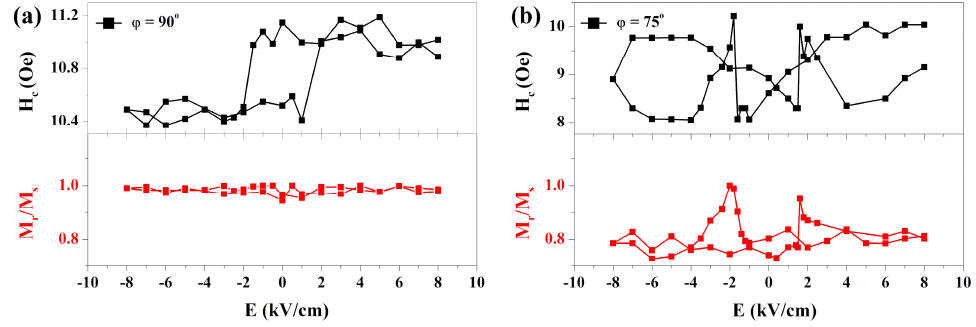
Figure 5. H c and M r /M s versus the electric field curves along the φ = 90° ( a ) and φ = 75° ( b ) directions.